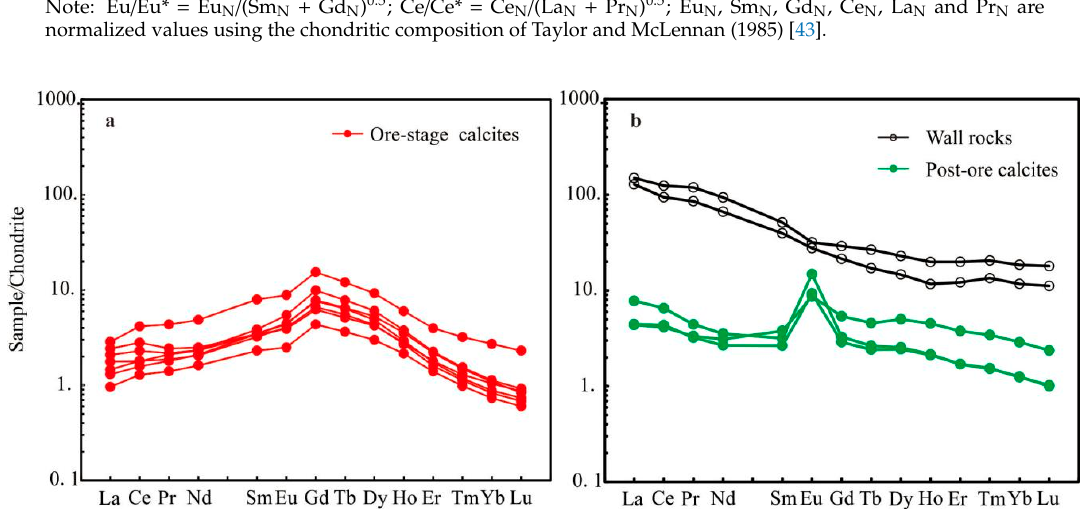
Figure 5. Chondrite-normalized REE patterns of wall rocks and calcites from the Zhesang gold